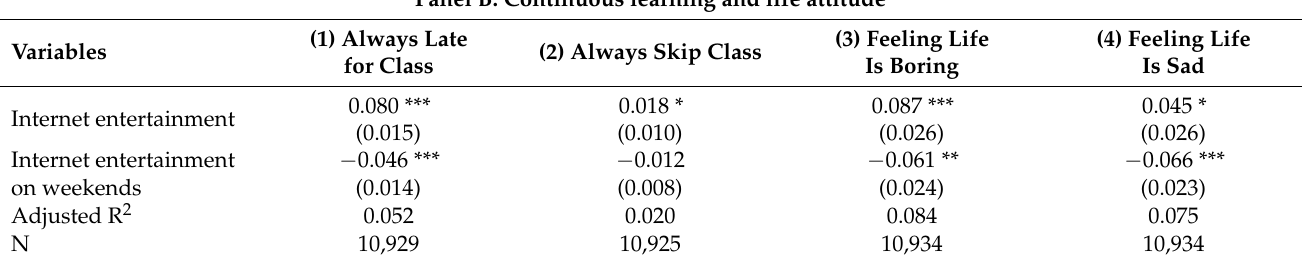
Panel B: Continuous learning and life